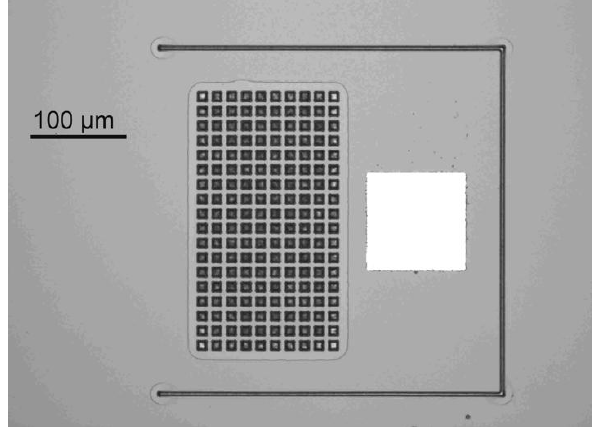
Figure 5. Top view of a 580 nm thick SiN flow sensor containing 180 holes with dimensions 10 × 10 µm 2